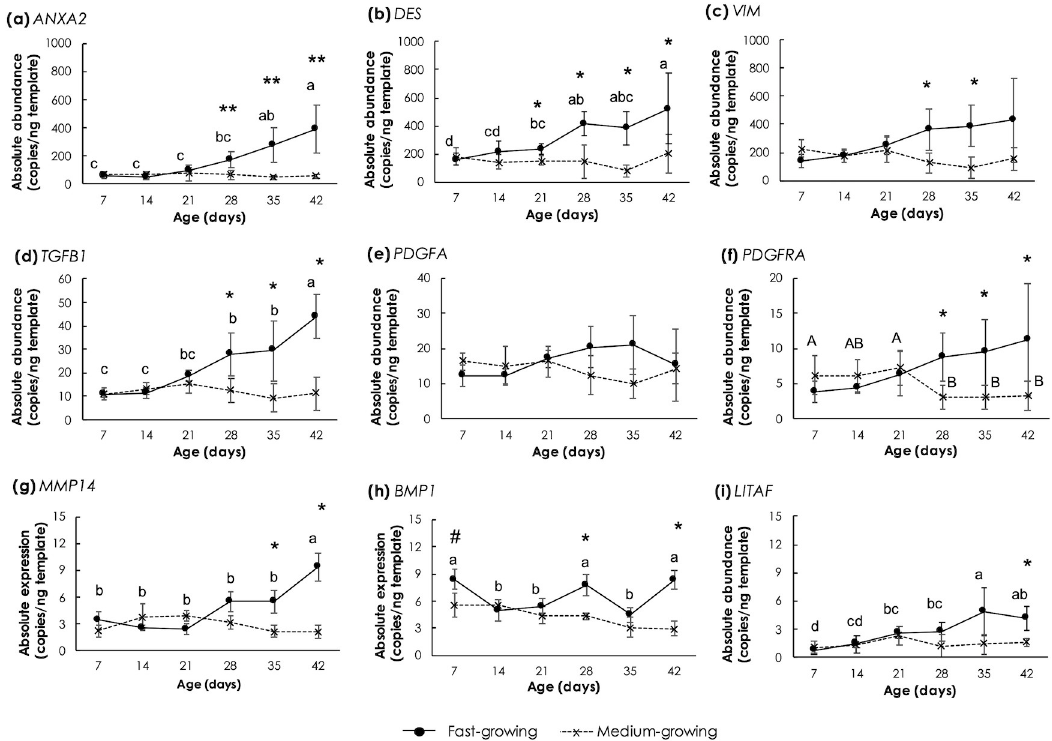
Fig 6. Absolute transcript abundance of genes associated with activities of satellite cells and fibro-adipogenic progenitors in Pectoralis major muscle of fast- and medium-growing chickens at different ages. The genes include (a) annexin A2 ( ANXA2 ), (b) desmin ( DES ), (c) vimentin ( VIM ), (d) transforming growth factor beta 1 ( TGFB1 ), (e) platelet-derived growth factor-alpha subunit ( PDGFA ), (f) platelet-derived growth factor receptor alpha subunit ( PDGFRA ), (g) Matrix metalloproteinase-14 ( MMP14 ), (h) bone morphogenetic protein 1 ( BMP1 ) and (i) lipopolysaccharide-induced tumor necrosis factor-alpha factor ( LITAF ). Markers and error bars depict mean and standard deviation (n = 5). Lower case letters indicate significant differences among fast-growing chickens. Upper case letters indicate significant differences among medium-growing chickens. Asterisks indicate significant differences between the two strains at the same age. � p < 0.05, �� p < 0.01, ��� p <